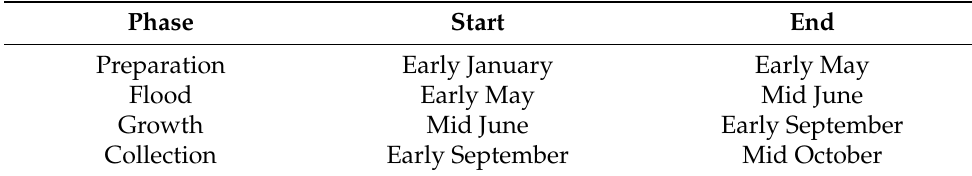
Table 2. Rice cultivation phases in the Coto Arrocero